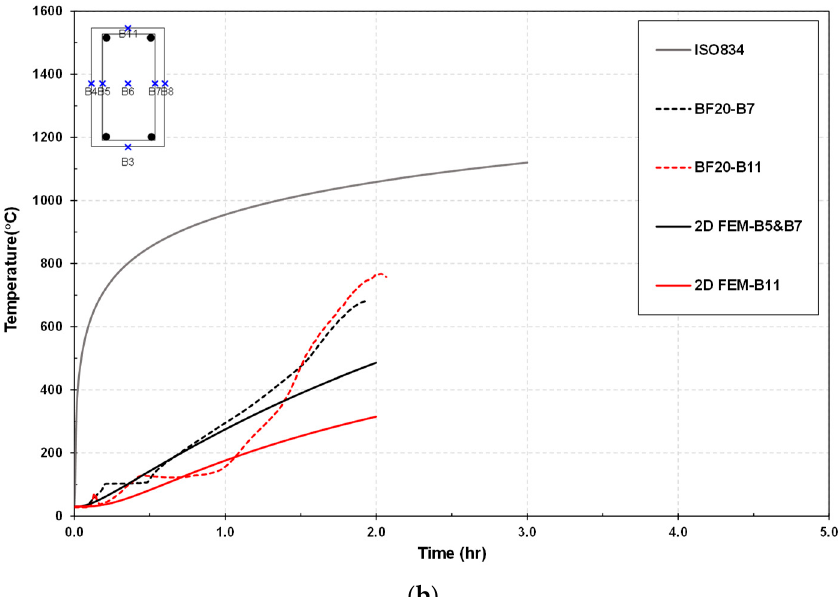
Figure 16. Comparison between prediction and test of the BF20 beam. ( a ) Reinforcements; ( b ) con- crete.